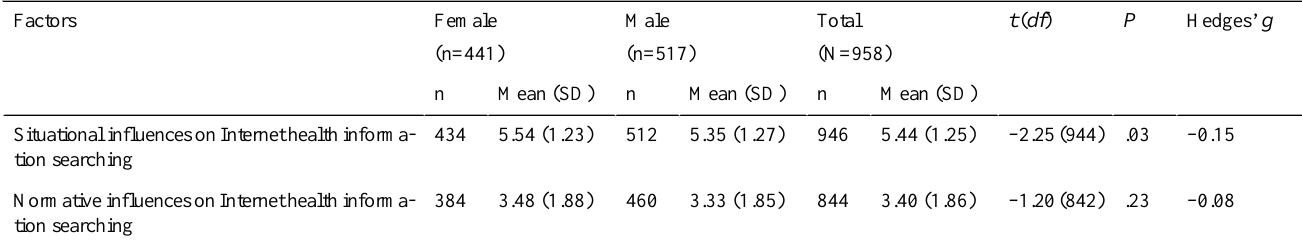
Table 6. Gender differences of weighted means of factor sum scores for situational and normative variables influencing Internet health information searching on an aggregate